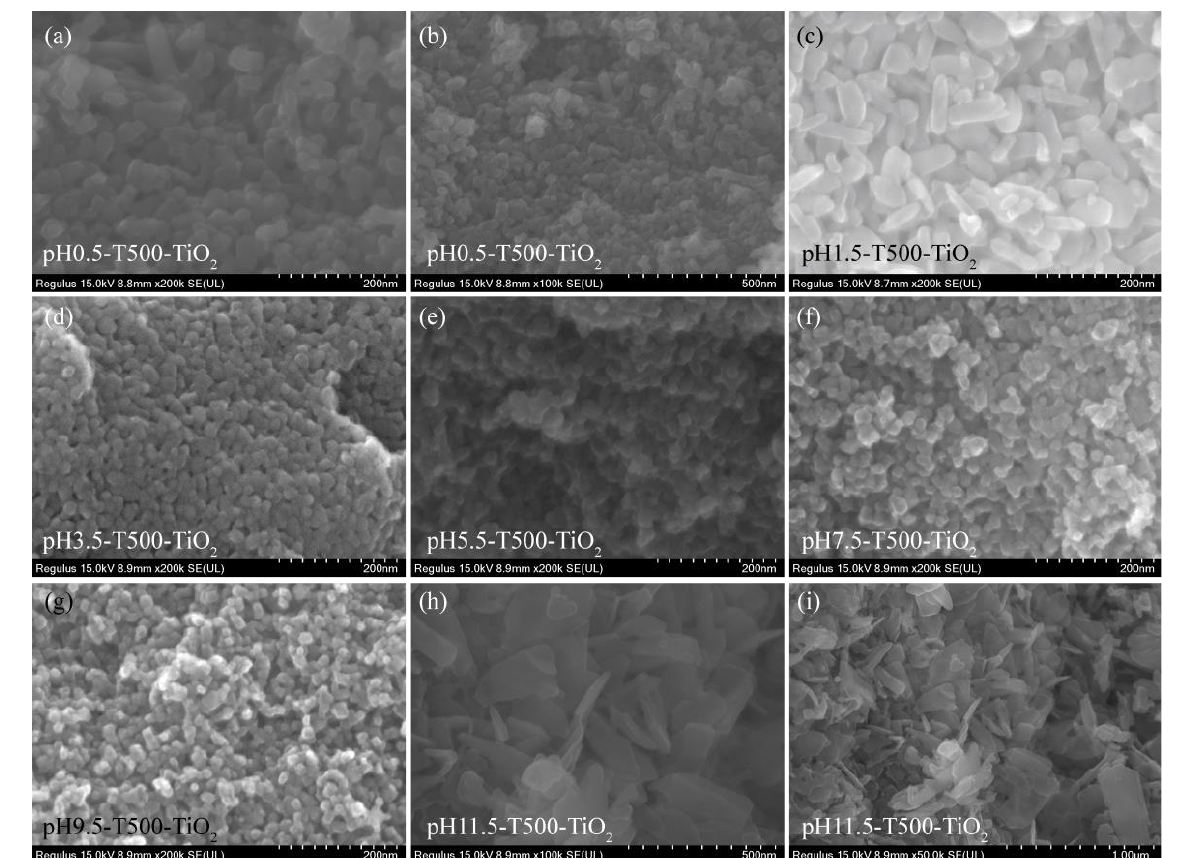
Figure 2. FESEM images of ( a , b ) pH0.5 − T500 − TiO 2 , ( c ) pH1.5 − T500 − TiO 2 , ( d ) pH3.5 − T500 − TiO 2 , ( e ) pH5.5 − T500 − TiO 2 , ( f ) pH7.5 − T500 − TiO 2 , ( g ) pH9.5 − T500 − TiO 2 , ( h , i ) pH115 − T500 − TiO 2 samples.